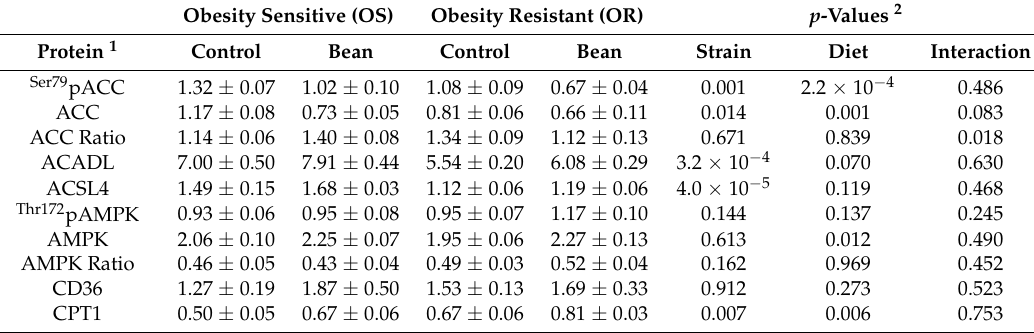
Table 4. Protein expression in